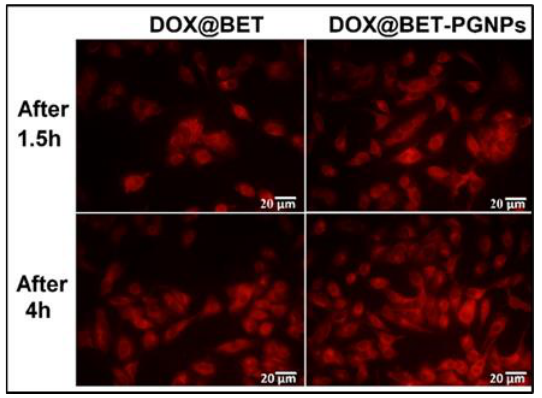
Figure 5. Cellular uptake studies of MCF-7 cell lines treated with the drug as well as nanoparticle encapsulated drugs. (DOX—doxorubicin; BET—betanin). (Reproduced with permission from [43]; Copyright 2019,